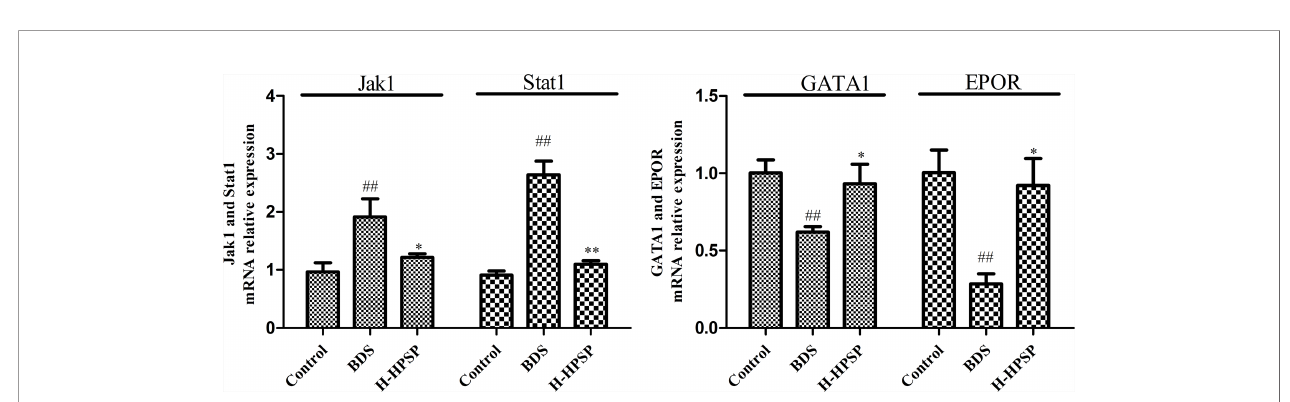
FIGURE 8 | The effects of H-SPSP on mRNA expression of Jak1, Stat1, EPOR and GATA1 in BDS mice. The relative gene expression values were calculated with the 2 − △△ Ct method. Each value represents the mean ± SD (n = 3); ## p < 0.01 versus Control group. * p < 0.05, ** p < 0.01 versus